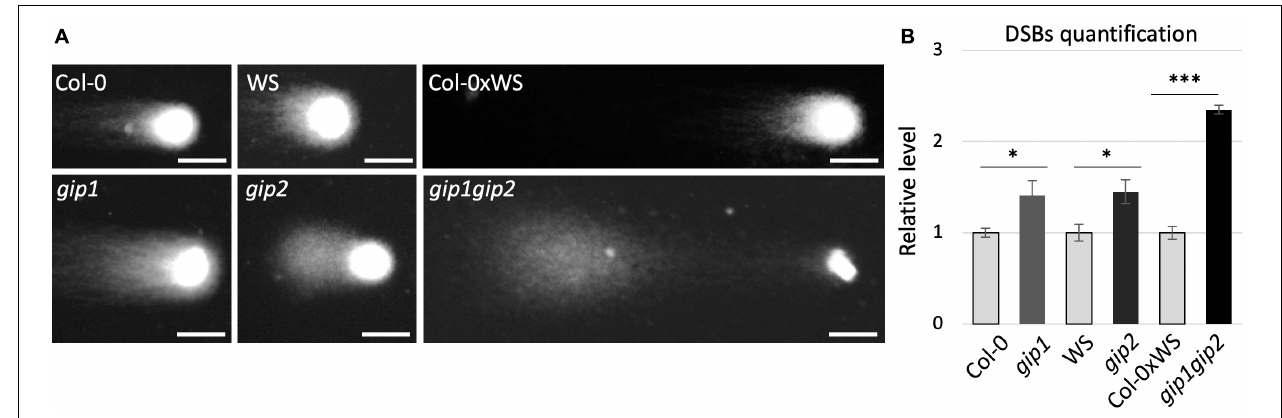
FIGURE 1 | Genomic instability is high in the gip1gip2 double mutant. (A) Nine-day-old Arabidopsis plantlets from single and double mutants ( gip1 , gip2 , gip1gip2 ) and their respective WT backgrounds (Col-0, WS, and Col-0xWS) were used for neutral comet assay. Representative images of comet assay are presented. Scale bar = 5 µ m. (B) The quantification of DSBs was performed on at least 100 nuclei by giving an arbitrary score to each comet figure as previously described (Lang et al., 2012). The Mann Whitney test was used and p -values are indicated as < 0.05 ( ∗ ) and < 0.001 ( ∗∗∗ ), respectively. The results were obtained from three independent experiments. Error bars indicate SEM.